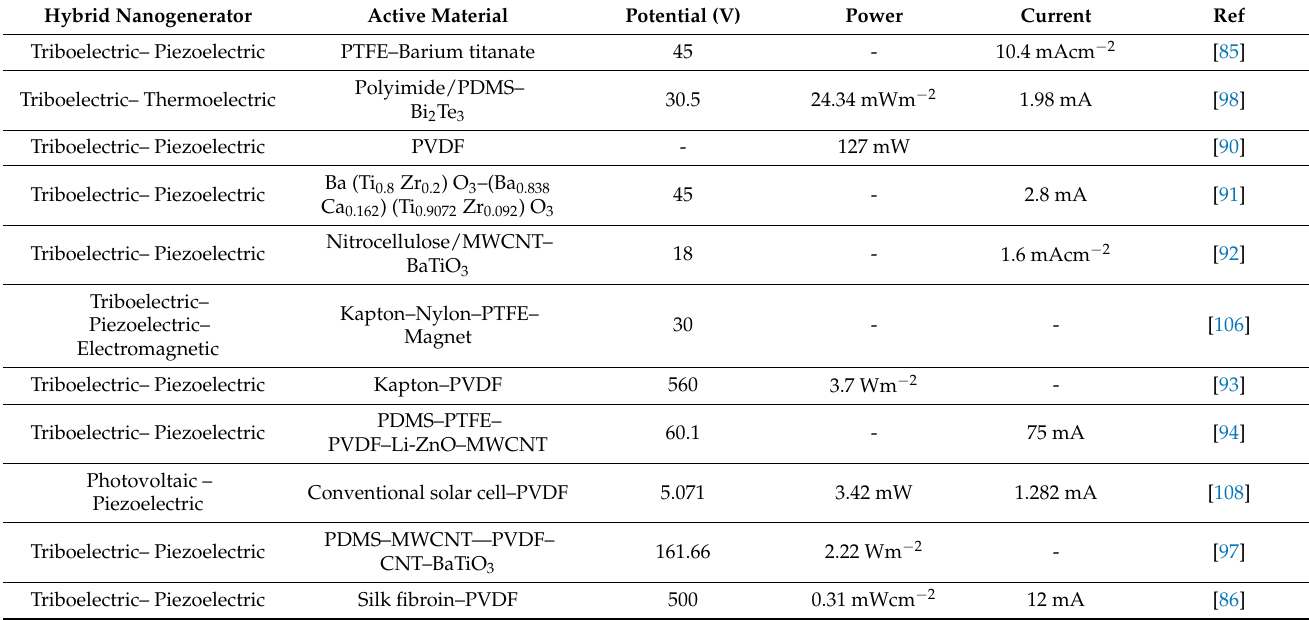
Table 3. Description of hybrid nanogenerators and corresponding performance in